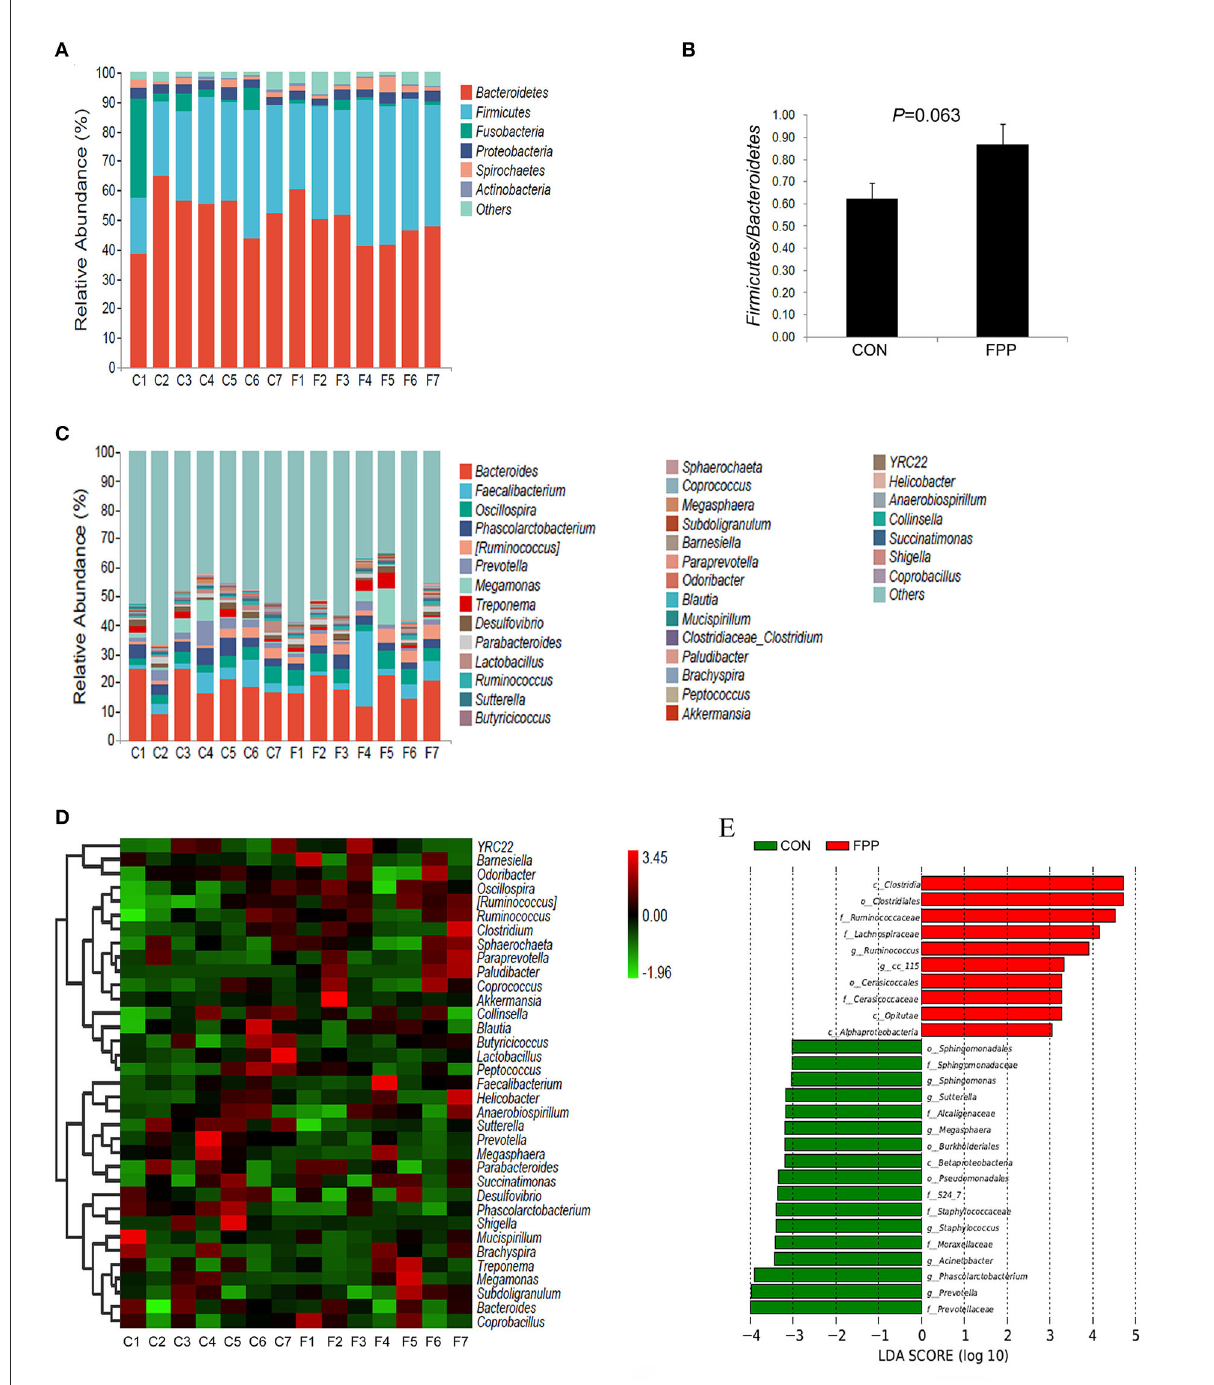
FIGURE4 Changes in the cecal microbial community in response to the addition of fermented plant product. Community taxonomic composition and relative abundance of cecal microbiota in individual birds from CON (C1–C7) and FPP (F1–F7) groups at phylum (A) and genus (C) levels. Ratio of Firmicutes to Bacteroidetes in each group based on their relative abundance (B) . Heatmap of bacterial communities in the CON (C1–C7) and FPP (F1–F7) samples based on the top 35 dominant genera. Rows and columns represent the samples and dominant genera, respectively (D) . Linear discriminant analysis (LDA) (LDA > 2.0, P < 0.05) of cecal microbiomes (E) . Histogram of LDA value distribution indicating significant bacterial differences between the CON group (green) and FPP group (red). The prefixes “c_,” “o_,” “f_,” and “g_” represent the annotated level of class, order, family, and genus. CON, basal control diet without additive; FPP, basal diet + 500 mg/kg ferment plant